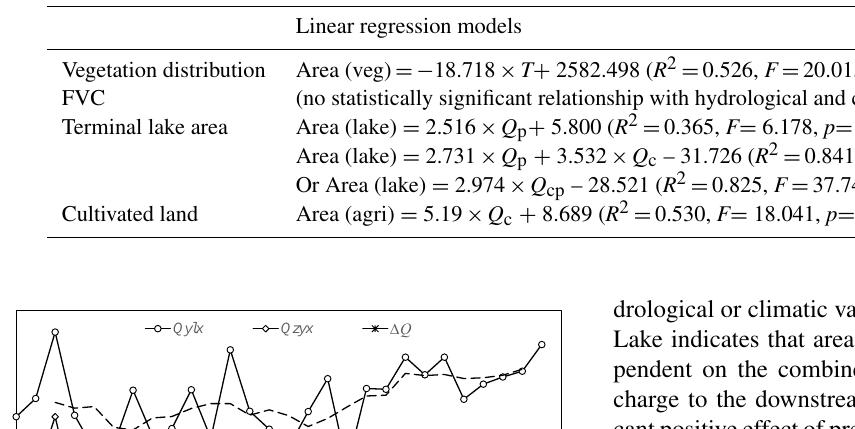
Table 2. Linear regression models for determining the areas of vegetation cover, cultivated lands and terminal lakes. Q p , Q c and Q cp stand for the annual discharge of previous (p), current (c) years and sum of previous and current years measured at ZYX station, respectively.